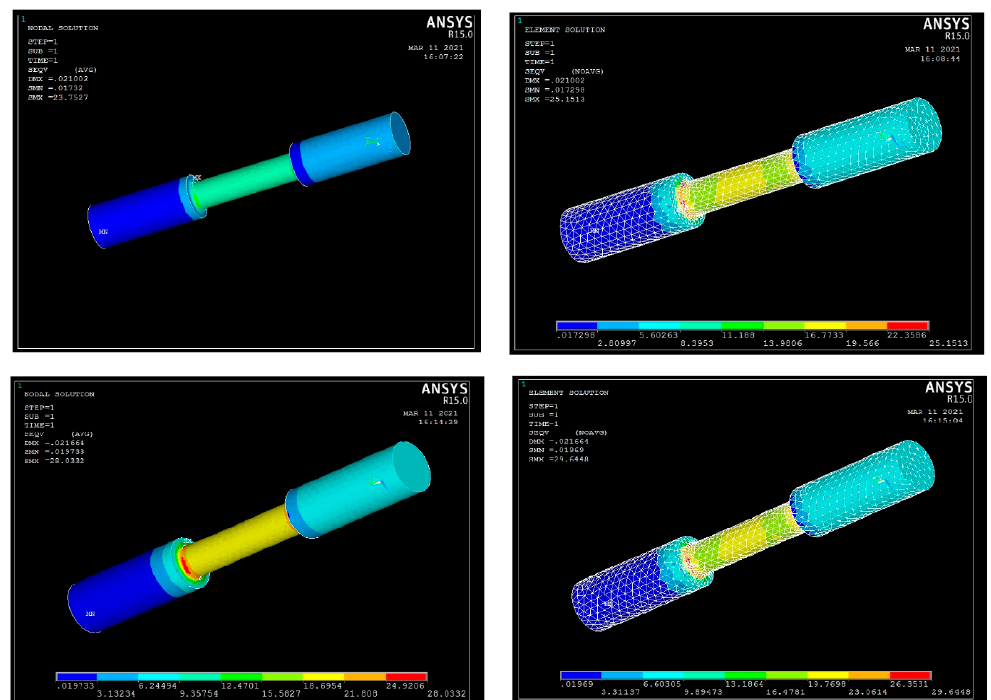
Figure 11. Analysis of nodal and elemental solution plot for tensile test on pure Al and composite in ANSYS.